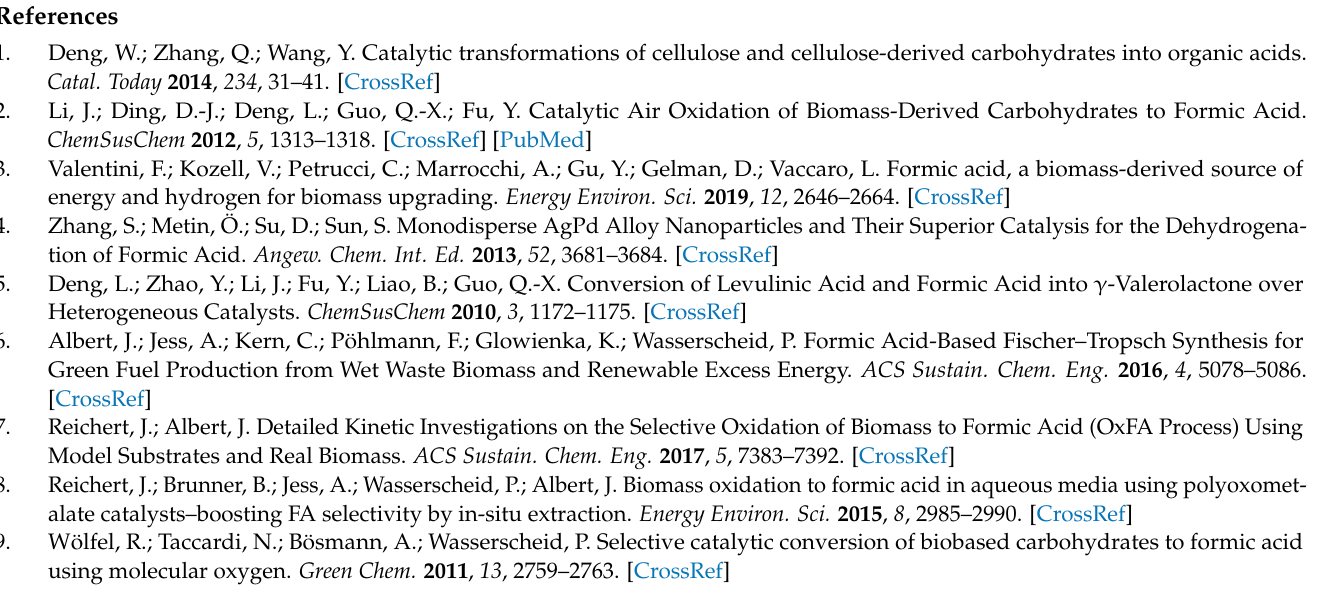
Figure S5: Correlation between formic acid yield and molar ratio of starch/catalyst; Figure